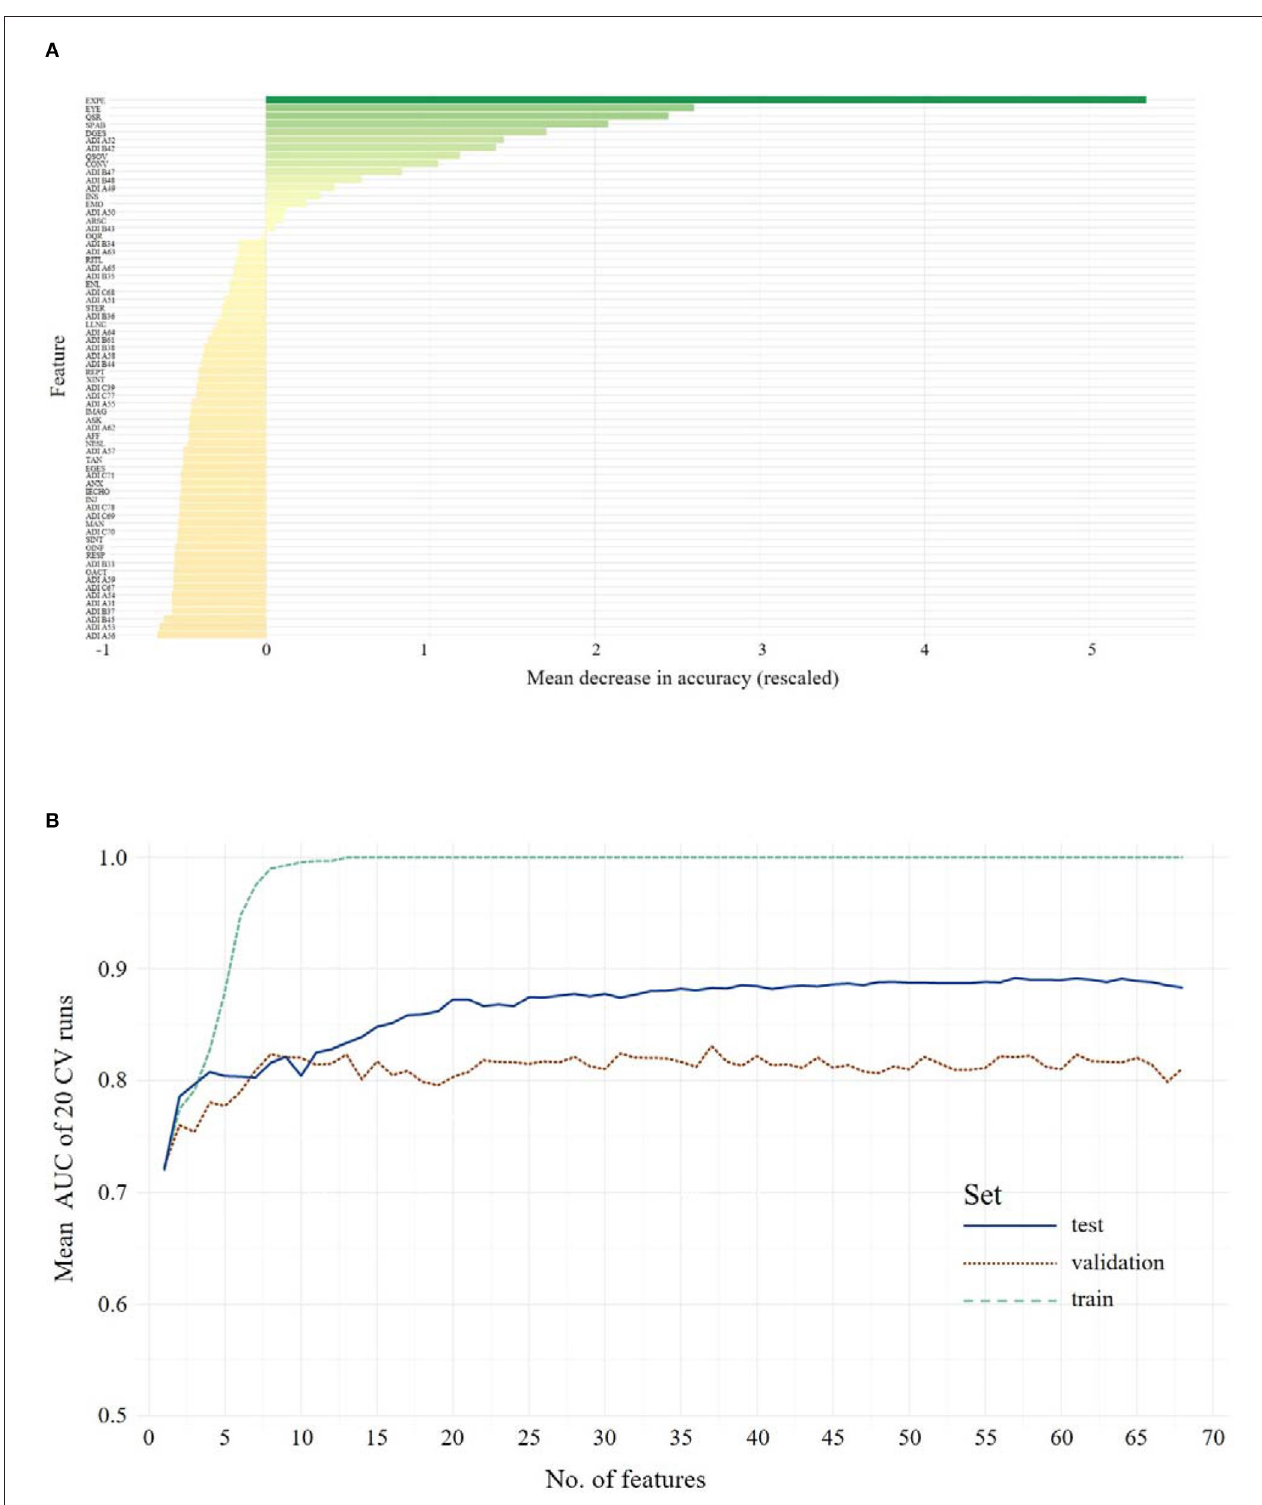
FIGURE 2 | The upper panel shows the overall ranking of feature importance for all features from ADOS and ADI-R data combined for Adolescents/Adults (A) . The figure depicts the ADOS and ADI items on the y-axis and on the x-axis its corresponding importance score, measured in mean decrease in accuracy (see text footnote 1). The lower panel (B) shows the mean AUC plotted against the number of model features from ADOS and ADI-R combined during model building (training, testing and validation of the classifiers) for Adolescents/Adults . A list of all included features and their abbreviations can be found in Supplementary Table 3 .